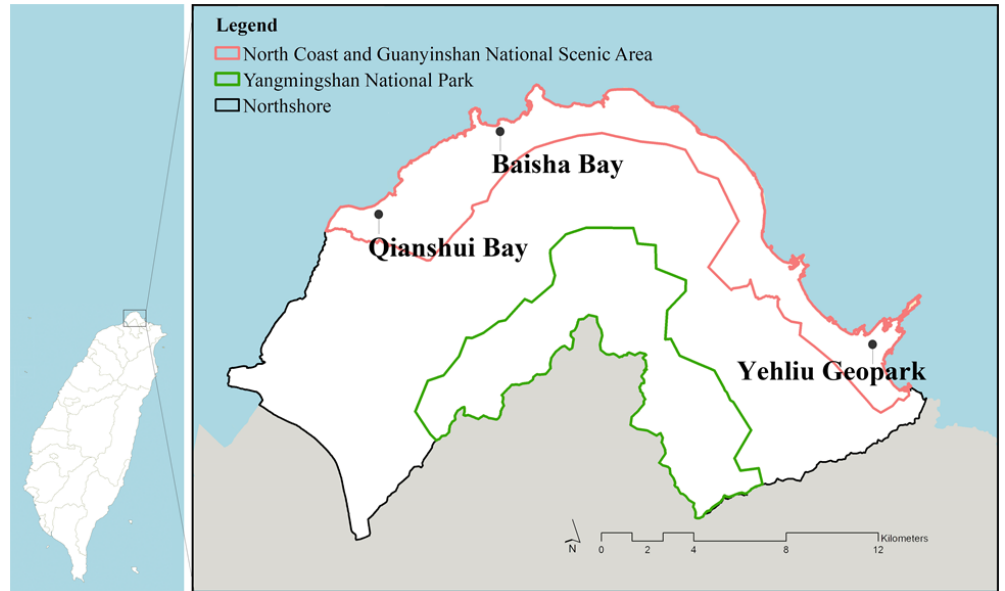
Figure 2. Study location with overlapping scopes of landscape policy.